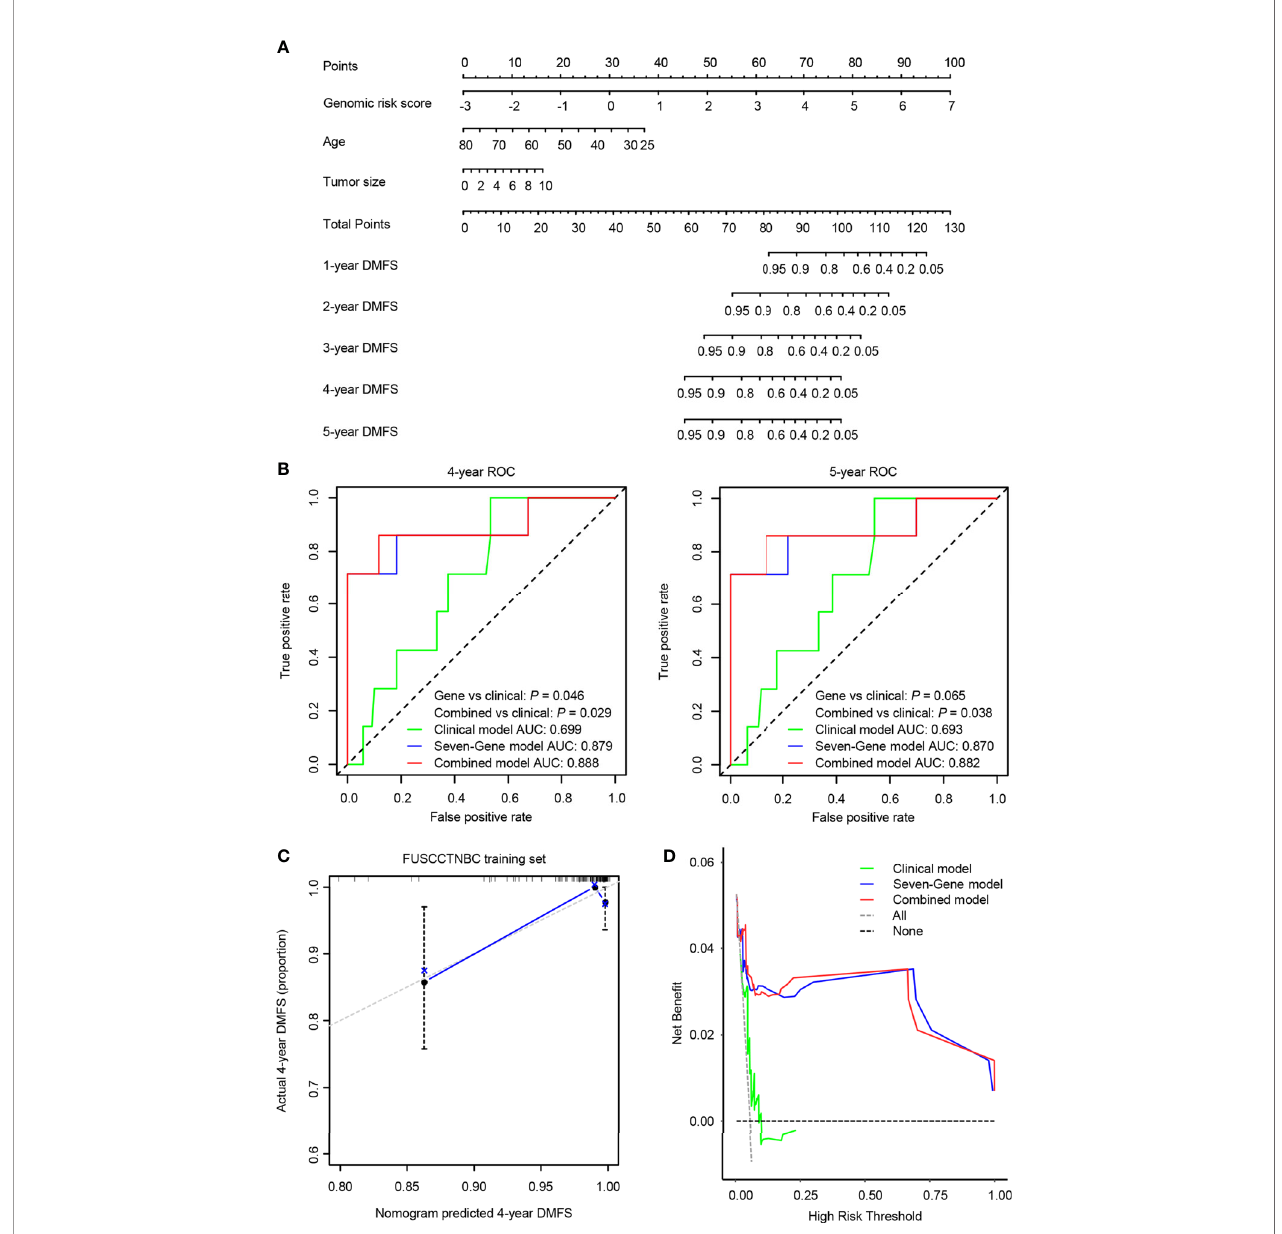
FIGURE 5 | A predictive nomogram was established in the training set. AUC, area under the curve. (A) The nomogram was built by the seven-gene risk score and clinical characteristics, including age and tumor size. (B) The time-dependent receiver operating characteristic (ROC) curves of the seven-gene model, clinical model, and combined model for 4- and 5-year distant metastasis-free survival (DMFS). The combined model was better than the clinical model for predicting 4-year ( P = 0.029) and 5-year ( P = 0.038) DMFS. (C) Calibration plots of the nomogram for 4-year DMFS. (D) Decision curve analysis (DCA) of the seven-gene model, clinical model, and combined model for 4-year